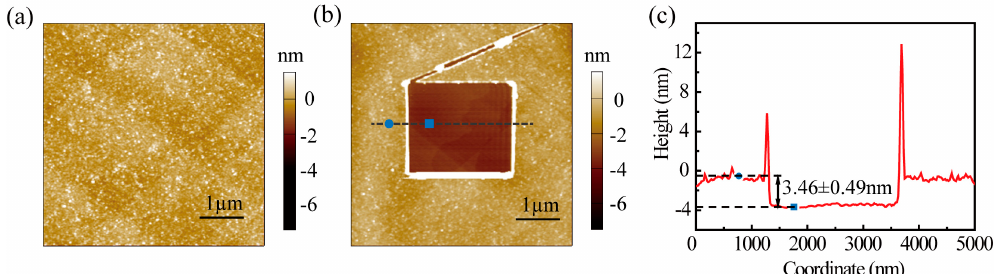
Figure 3. Image and morphology date of BSA monolayer. ( a ) Typical AFM image of BSA monolayer.